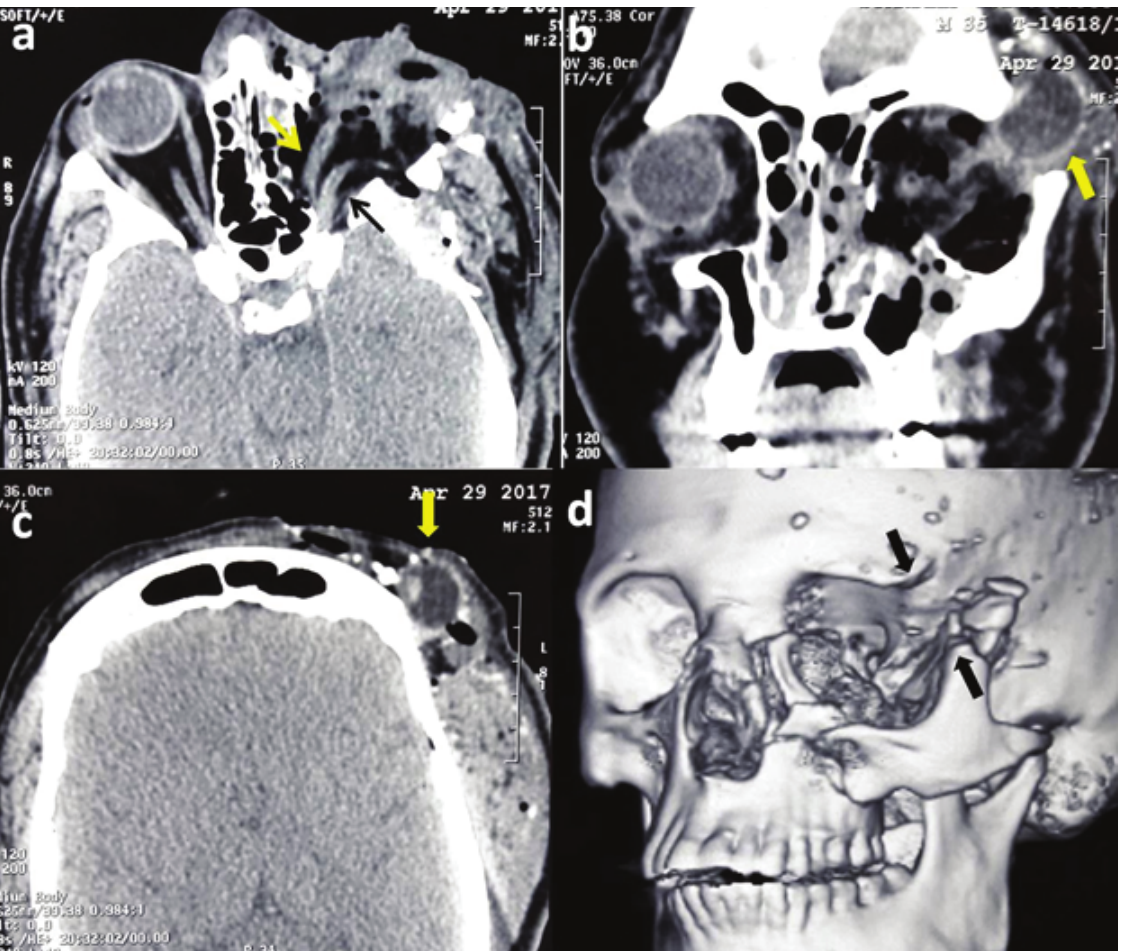
Figure 1. Computed tomography images of the orbit, brain, and 3D face reconstruction. (a) Axial scan illustrates left orbital fractures, pneumo-orbit, lost eyeball with transected medial rectus (yellow arrow), and optic nerve (black arrow). (b) The coronal section shows a luxated eyeball (yellow arrow) through the fracture space, pneumo-orbit, and left maxillary hemosinus. (c) The superior axial section shows the luxated eyeball beneath the anterior fibers of left temporalis muscle with air pockets and multiple small bone fragments. (d) The virtual reality image illustrates the left displaced tripod fracture of the zygomatic bone and a contributory wide bony space created (two black